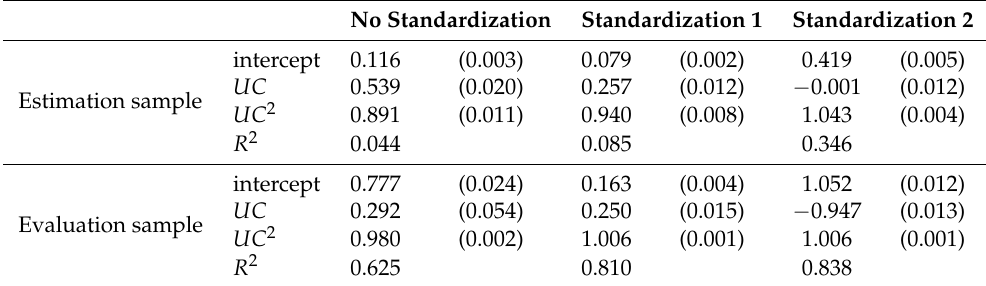
Table 8. Regression of squared forecast error of the analyst earnings forecasts on the unpredictable component and its square: FE 2 = β 0 + β 1 UC + β 2 UC 2 . We did this for all 316 firms and